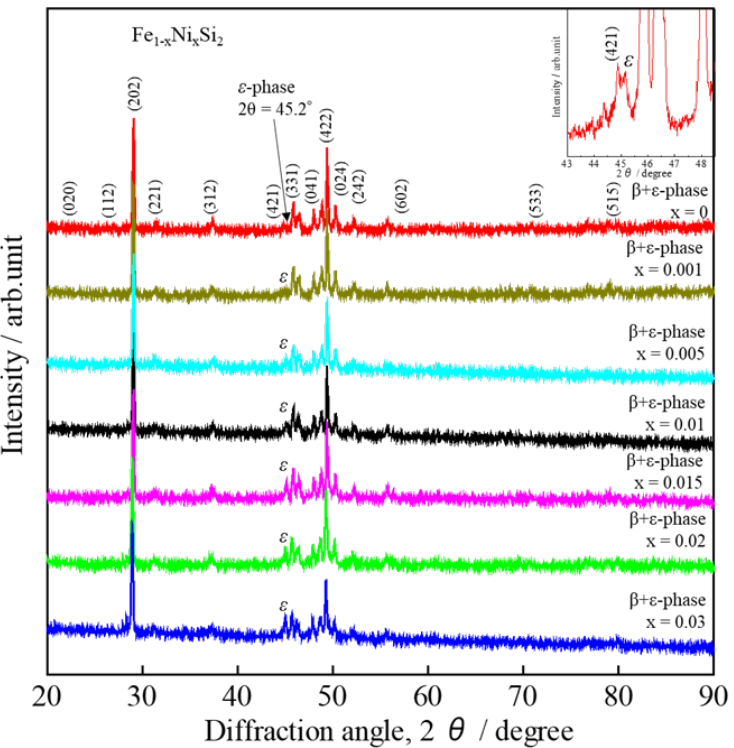
Figure 1. X-ray diffraction patterns of β -Fe 1−x Ni x Si 2 (0 ≤ x ≤ 0.03) at room temperature.